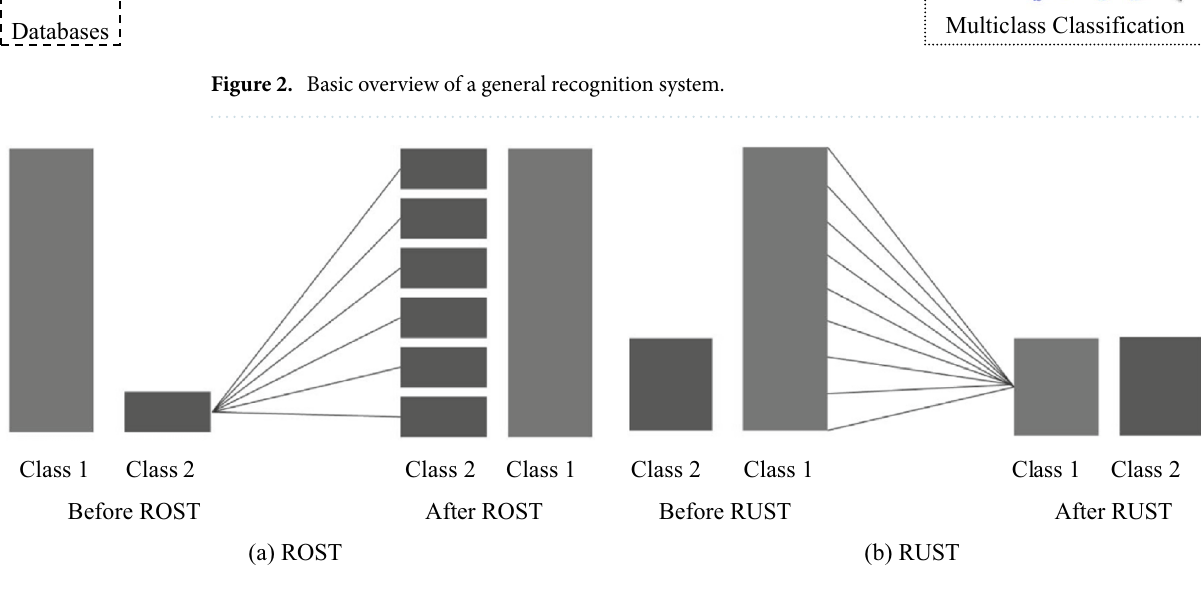
Figure 3. A sample showing resampling techniques on two class